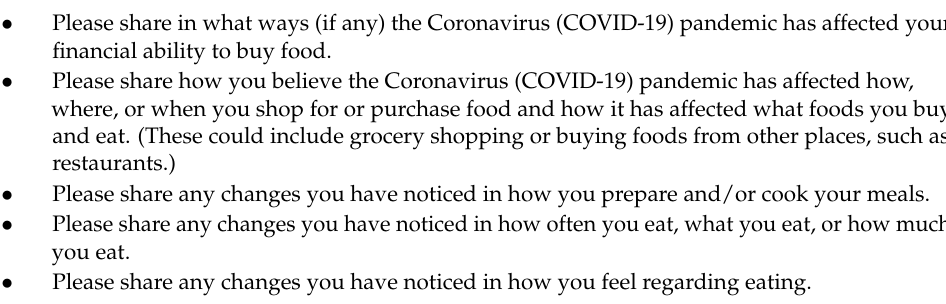
Table 1. Qualitative Survey